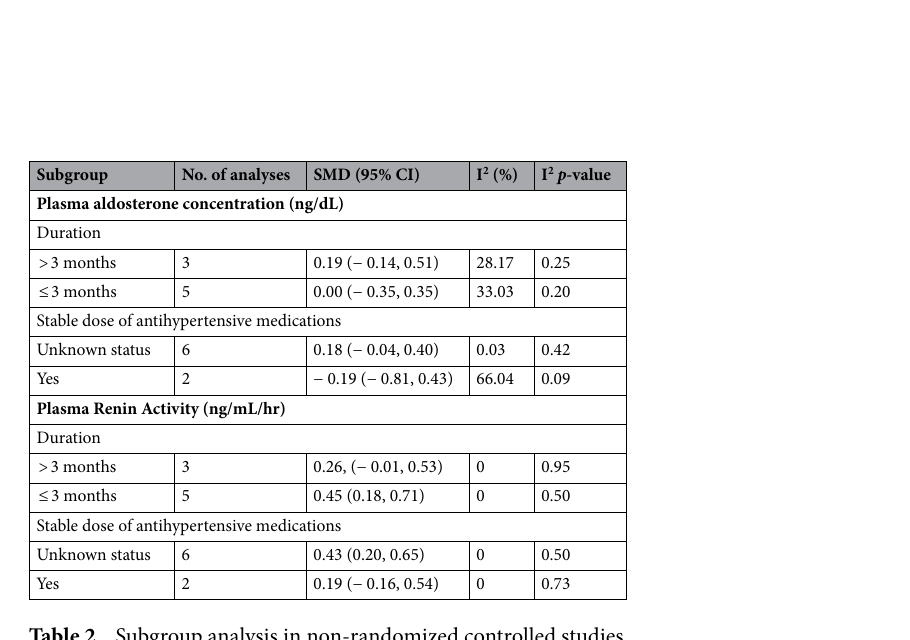
Table 2. Subgroup analysis in non-randomized controlled